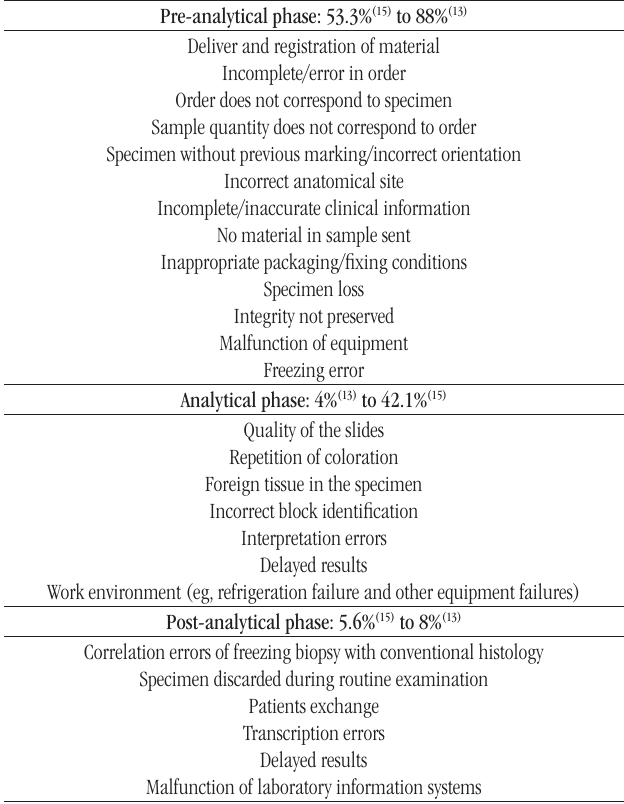
taBLE − Distribution of errors according to the operating process phase and examples (13,